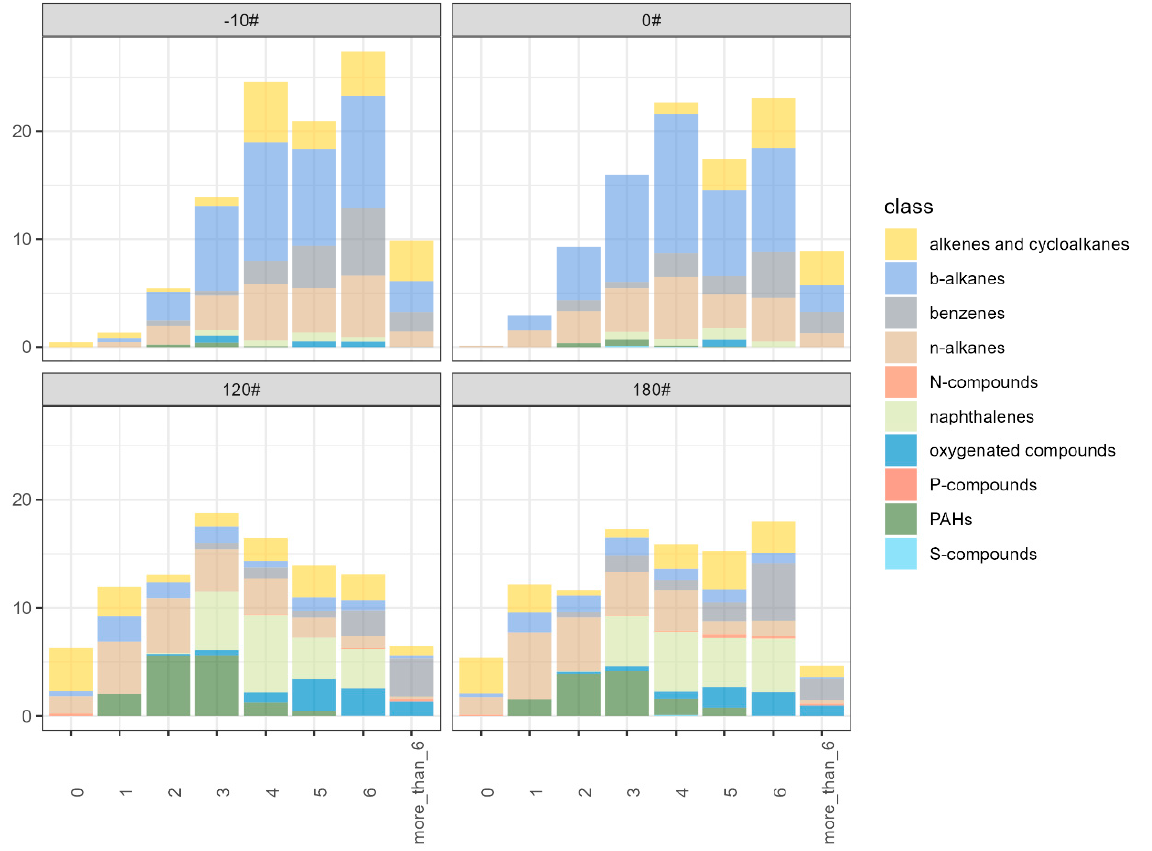
Figure 4. Average volatility distribution of organic emissions for -10#, 0#, 120#, and 180# marine fuels based on the VBS model. The x-axis is the saturated vapor concentration (C*) in μ g m − 3 .